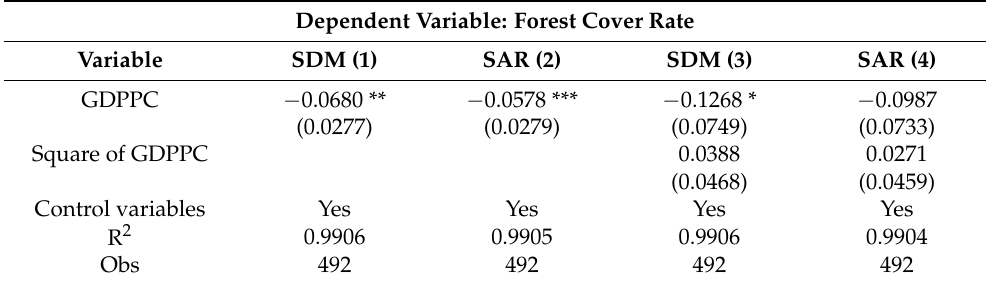
Table 10. Estimation results of effects of economic development on forest resource